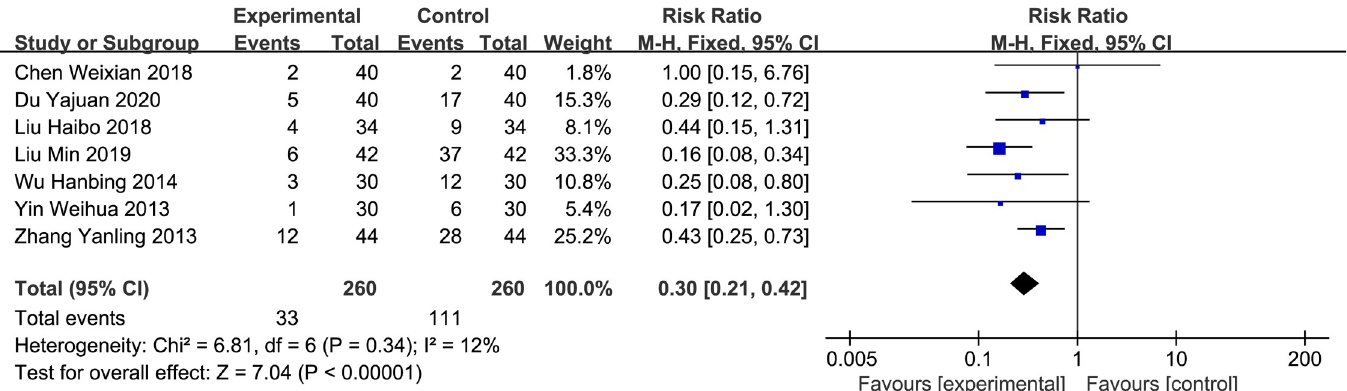
Fig 7. Forest plot of the incidence of nausea and vomiting between experimental and control group.